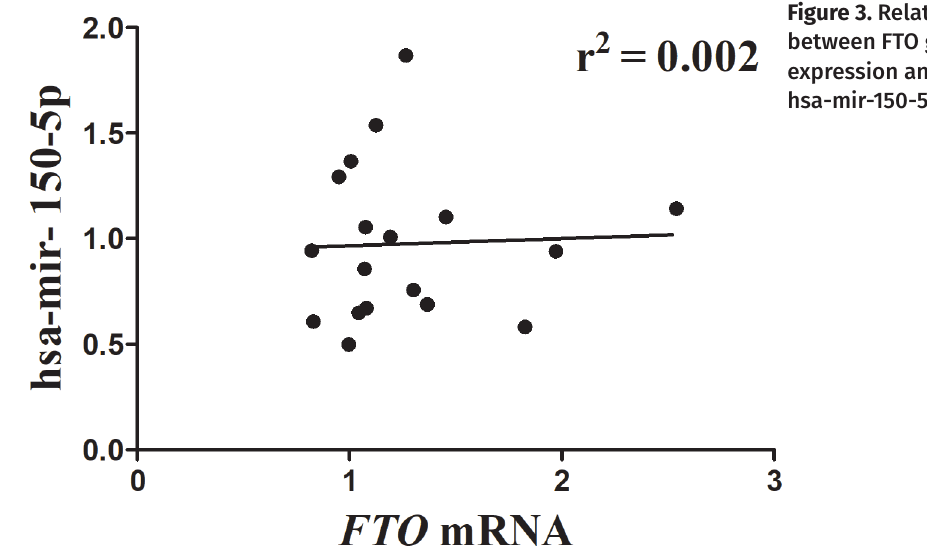
Figure 3. Relationship between FTO gene expression